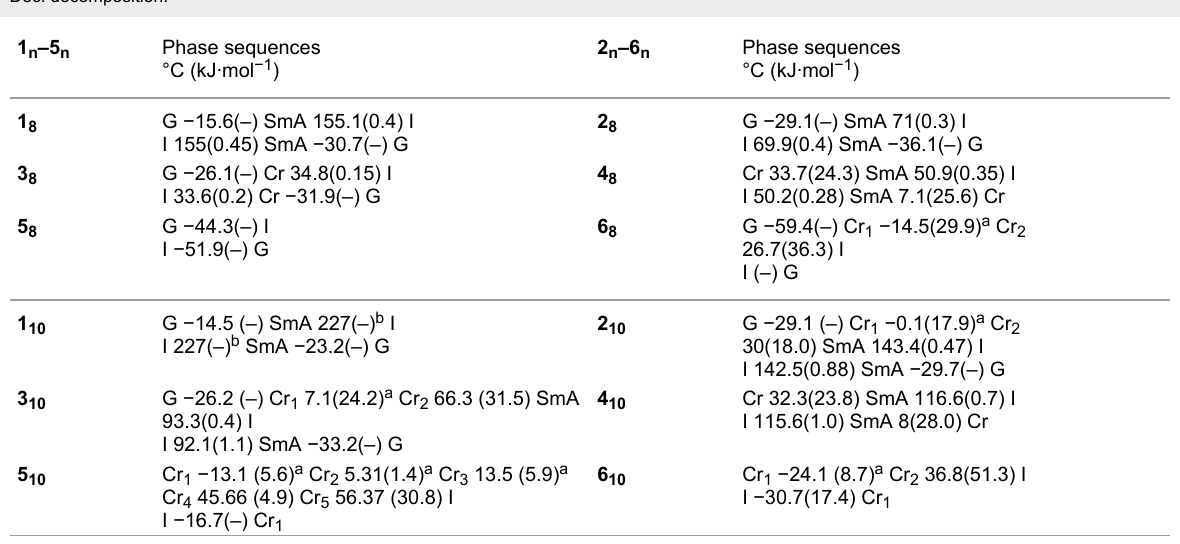
ionic liquids between −80 °C to 200 °C (ESI). The DSC graphs for the compounds with short aliphatic chains exhibit a glass transition during the cooling process rather than a crystalliza- tion peak. In contrast, increasing the chain length ( n > 10) we have almost detected a crystalline transition. During the following heating process, most of these compounds ( n > 10) show crystalline polymorphism with some rearrangement between different solid organizations (cold crystallization, transition crystal to crystal) (Table 1). The transitions between crystal and mesomorphic state and also the clearing point increase with the chain length, allowing liquid